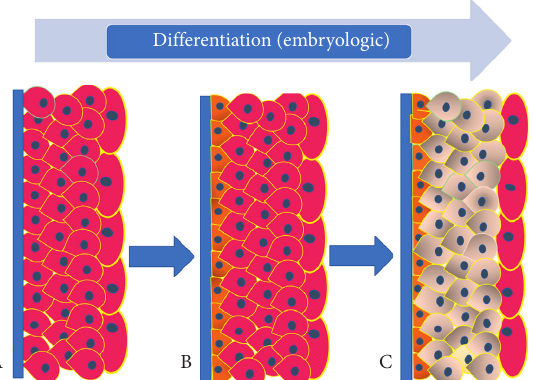
Figure 8: (a) Cartoon depicting stages of differentiation during the embryologic development of the urothelium. During the early stages, the developing urothelium retains CK20 expression normally seen in the cloaca. During this stage, no basal layer is present. (b) During the development of urothelium, the basal layer cannot be demonstrated by staining for CK5/6. (c) Final stage of urothelial differentiation with normal expression of CK20 limited to the umbrella cells and presence of normal basal layer manifesting expression of CK5/6.